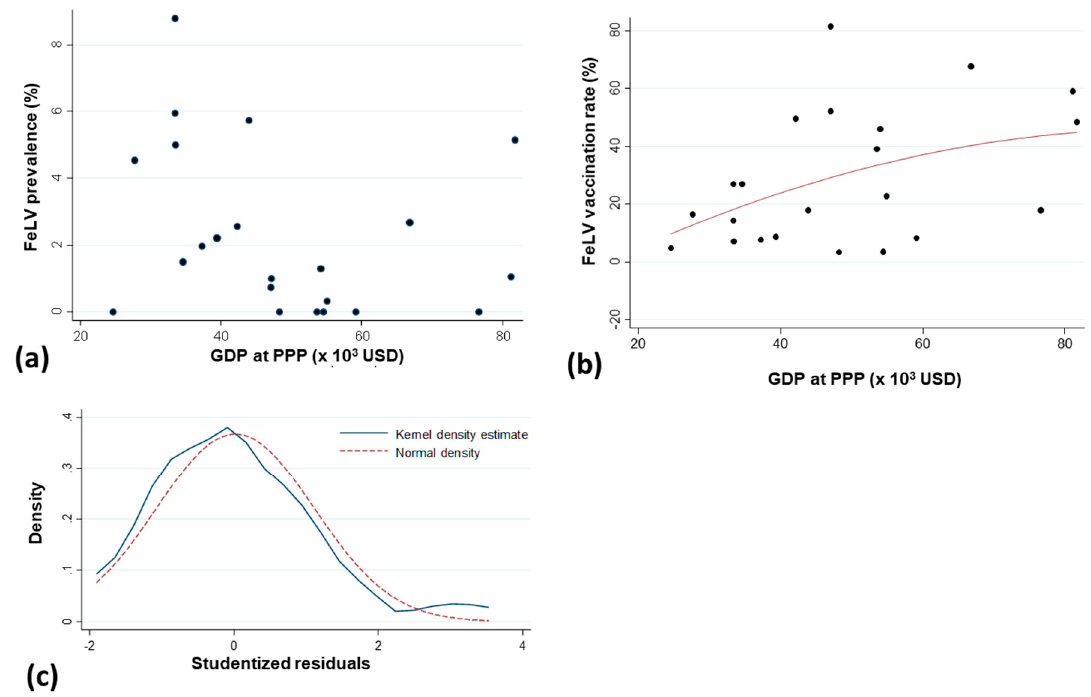
Figure 4. Relation between FeLV prevalence or FeLV vaccination rate and the gross domestic product (GDP) per capita purchasing power parity (PPP). ( a ) Relation between FeLV prevalence and GDP per capita using PPP in US dollars (USD); ( b ) Linear relation between FeLV vaccination rate and GDP per capita using PPP in USD (with the black points, the observed values; the line, the linear relation between the FeLV vaccination rate and the GDP per capita PPP and its 95% confidence interval, with the following equation: FeLV_vacc = − 0.9698946 + (0.6052006 * GDP); ( c ) Density of the studentized residuals with the kernel density estimate and the normal density as reference. Kernel = epanechnikov, bandwidth = 0.4433.